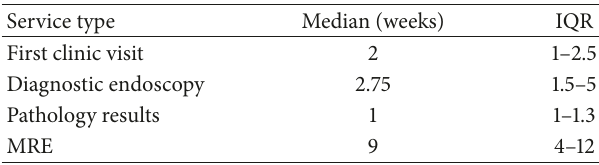
Table 2: Median and interquartile range (IQR) of wait times (in weeks) for services to children with IBD in